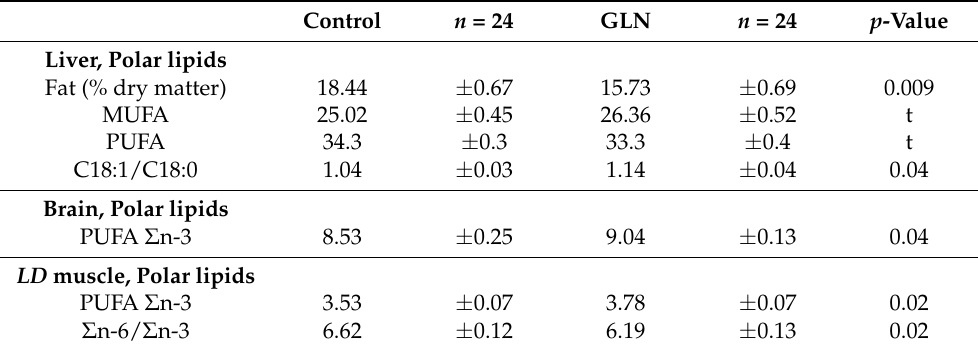
MUFA = sum of monounsaturated FA, PUFA = sum of polyunsaturated FA, LD = Longissimus dorsi , SE = standard error, t = 0.1 > p > 0.05. Maternal Treatment Interactions Regarding the LBIW group, control newborns showed greater Σ n-6 FA values than